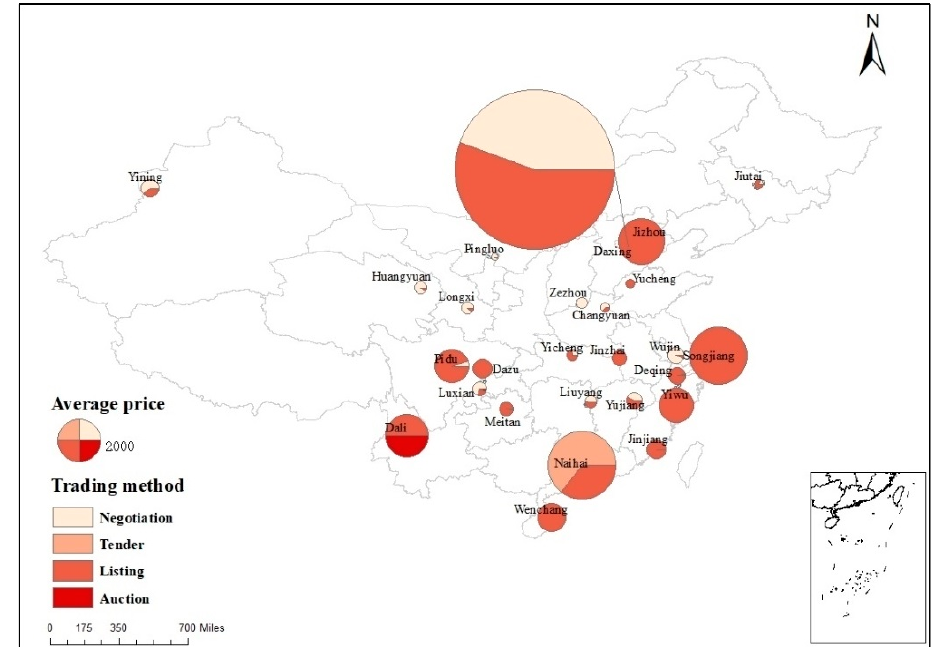
Figure 7. Trading methods and average price in 26 pilot areas.